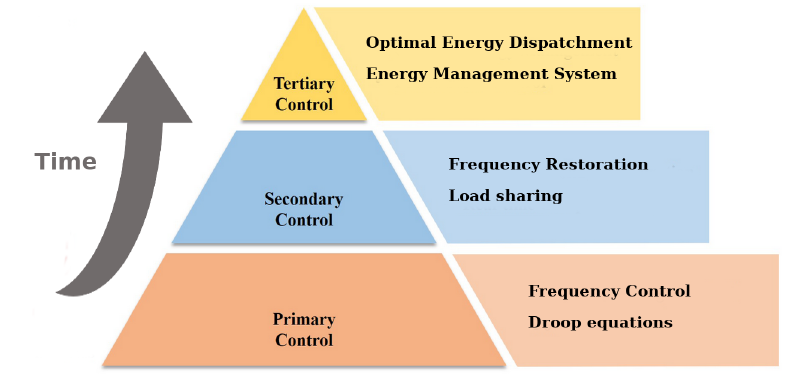
Figure 2. Control levels of the electrical